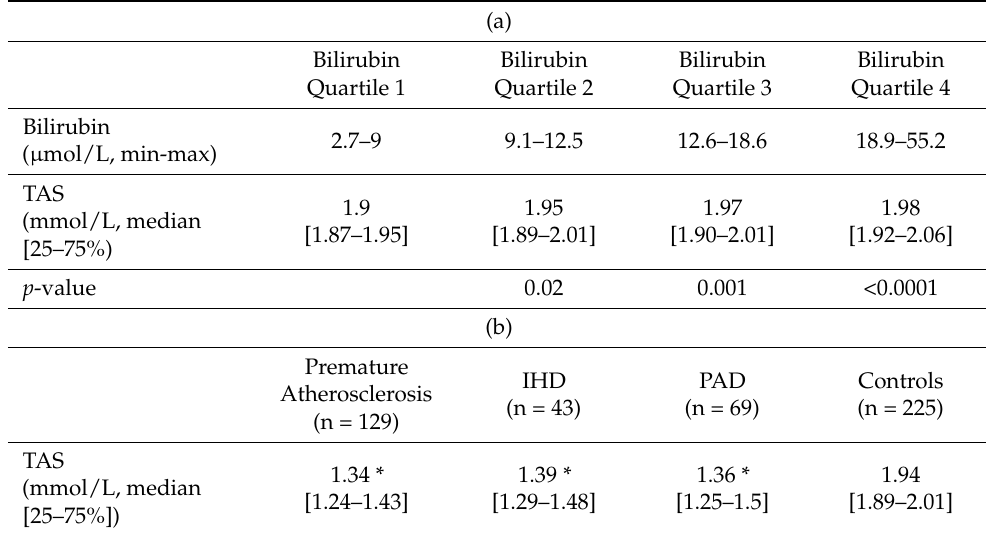
ANOVA on Ranks with Dunn ’ s post hoc analyses were used for all pairwise comparisons. * = p <